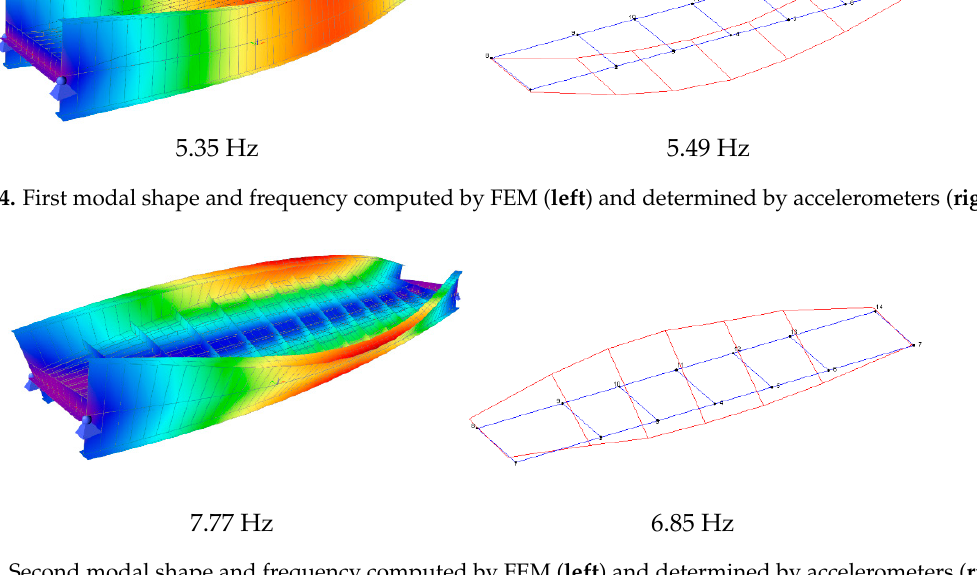
Figure 15. Second modal shape and frequency computed by FEM ( left ) and determined by accelerometers ( right ).